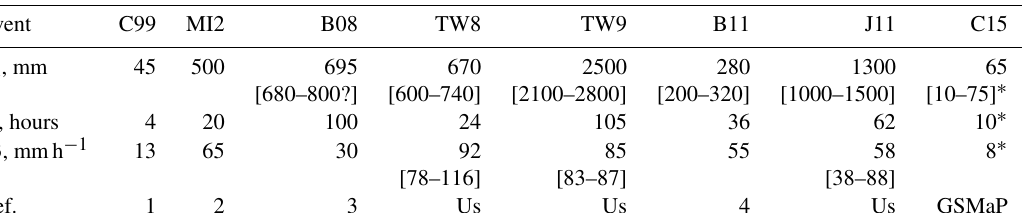
Table 1. Rainfall data summary, containing the total rainfall, duration and maximum 3h intensity for each storms. For TW8, TW9 and J11, we indicate the range for the three indexes that could be estimated from three gauges near the zone of maximal landsliding. We cannot perform this analysis for MI2 and C99, and can only assess a range of R t for B08 and B11. For B08 the question mark indicates that the upper bound of R t is under-constrained and taken as 115% of the best estimate. For C15, we indicate by a star that we could only access